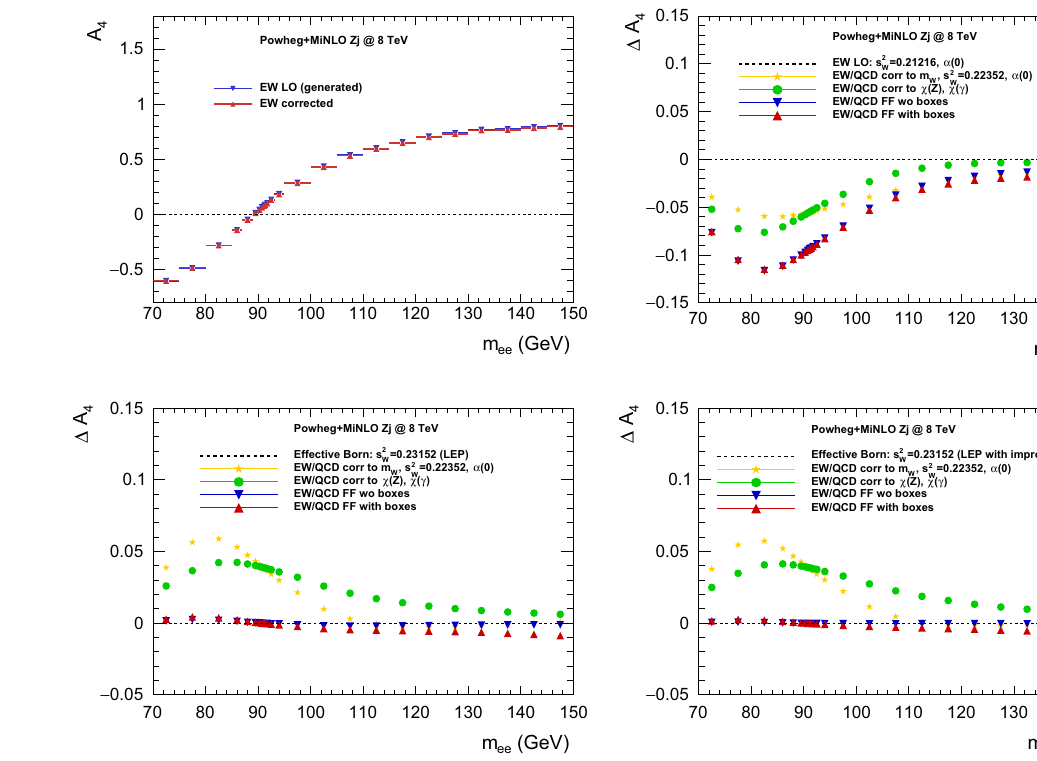
thanks to properties of spin amplitudes discussed in